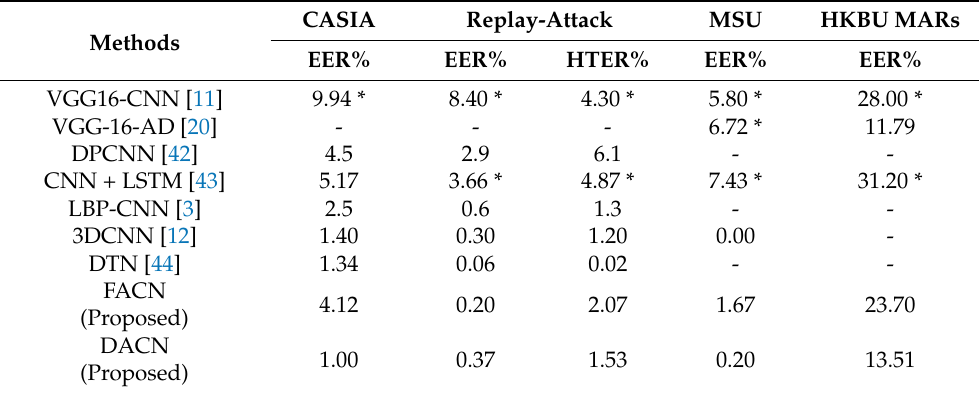
Table 3. Performance comparison (‘*’ indicates the performance score which follows the reference implemented by